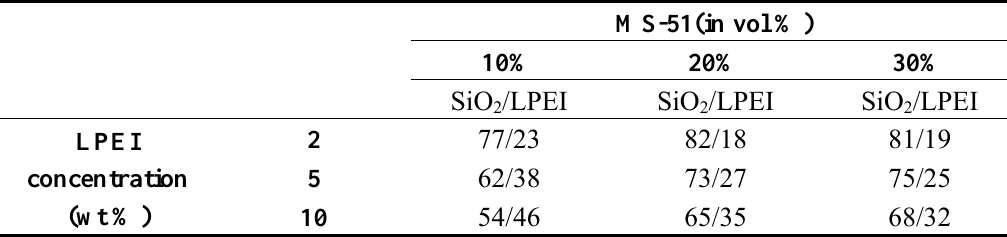
hybrids obtained from different 2